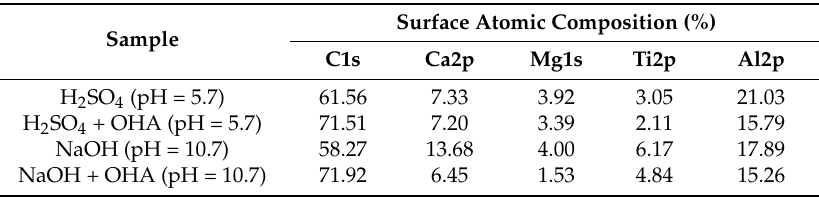
Table 5. Relative contents of elements on titanaugite surface.